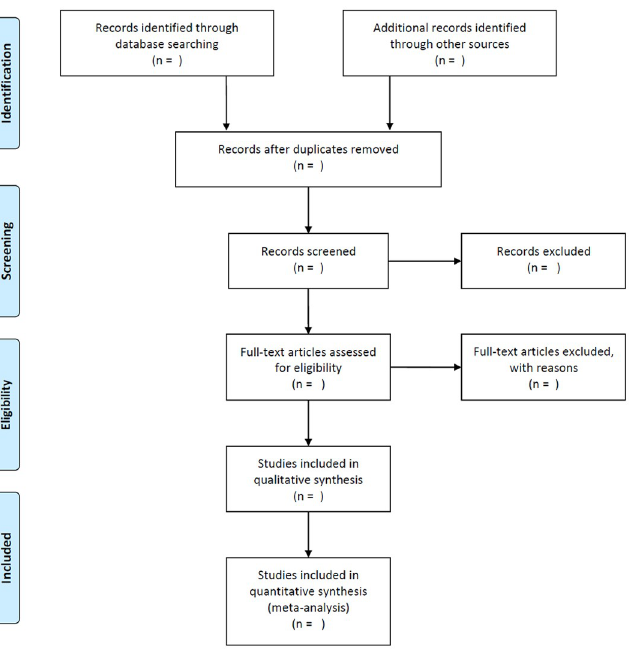
Fig 1. Flowchart of study